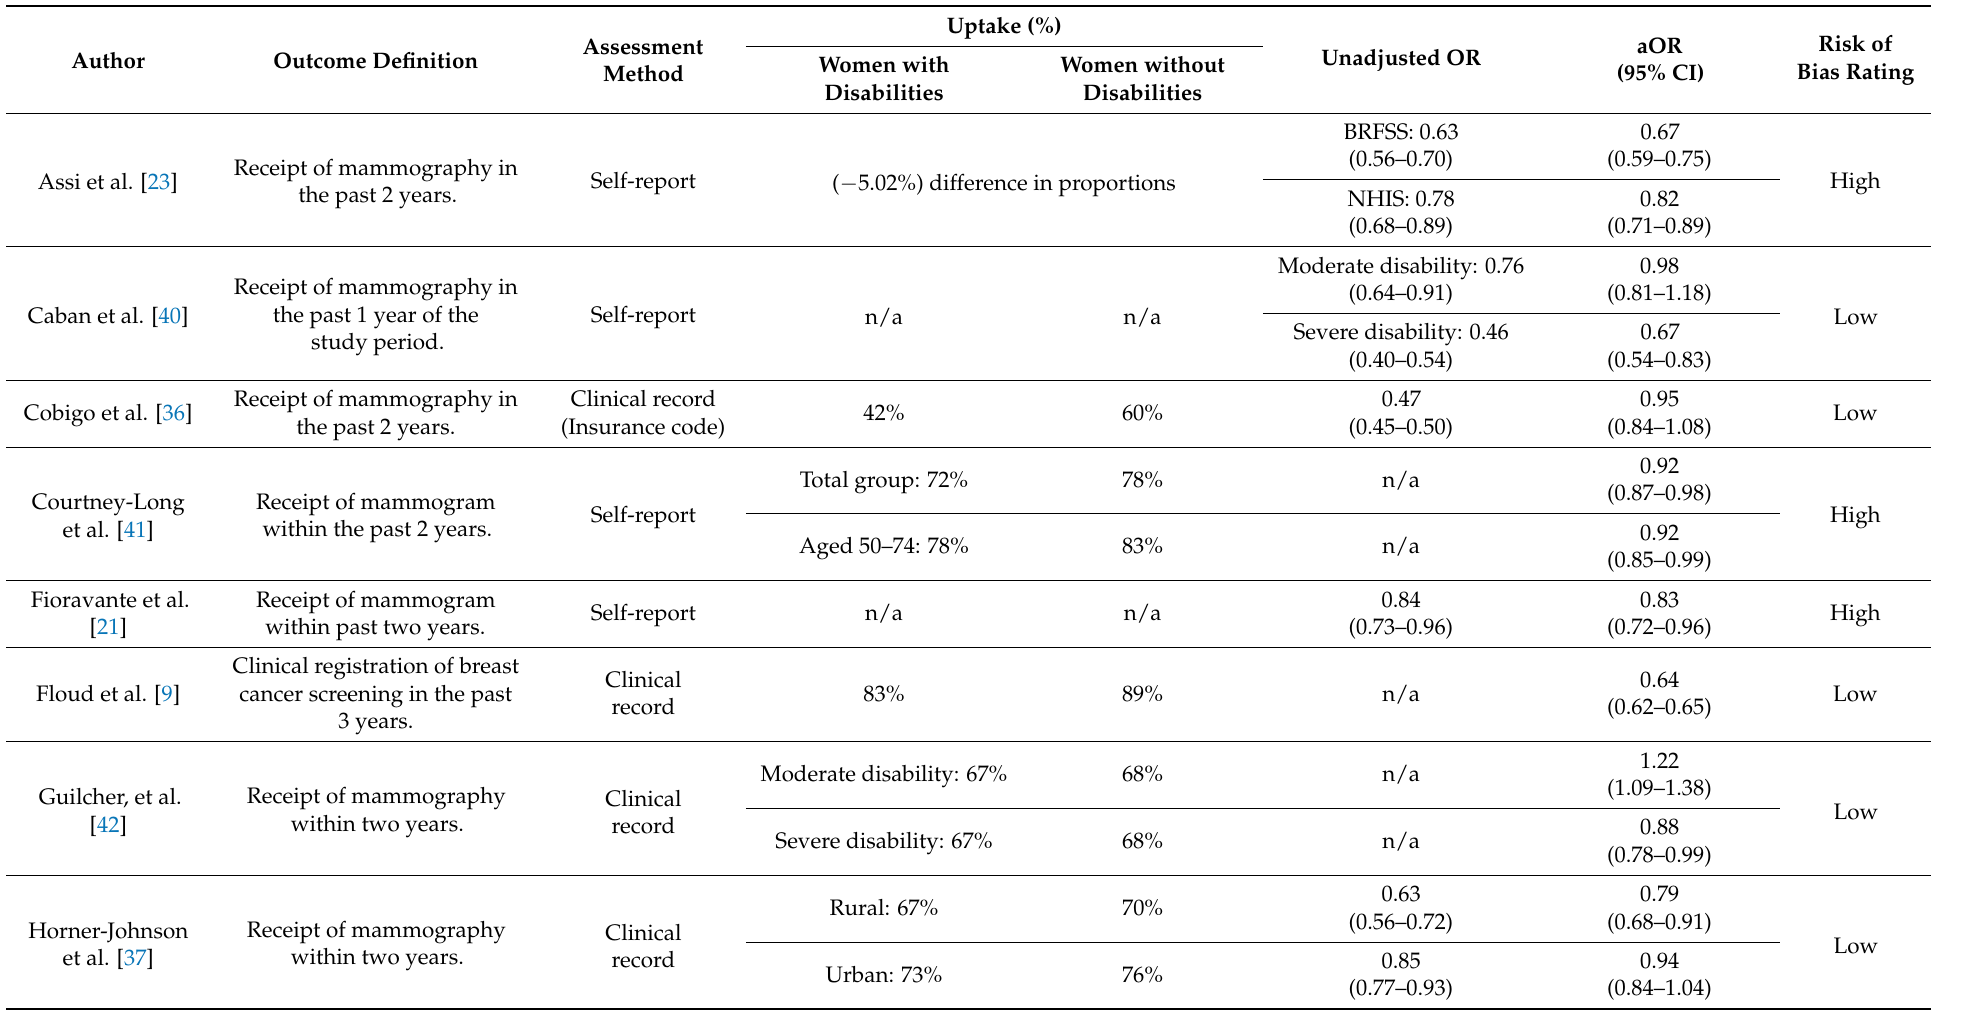
Table 2. Details on outcome measurement and estimate of association between presence of any disability in women and breast cancer